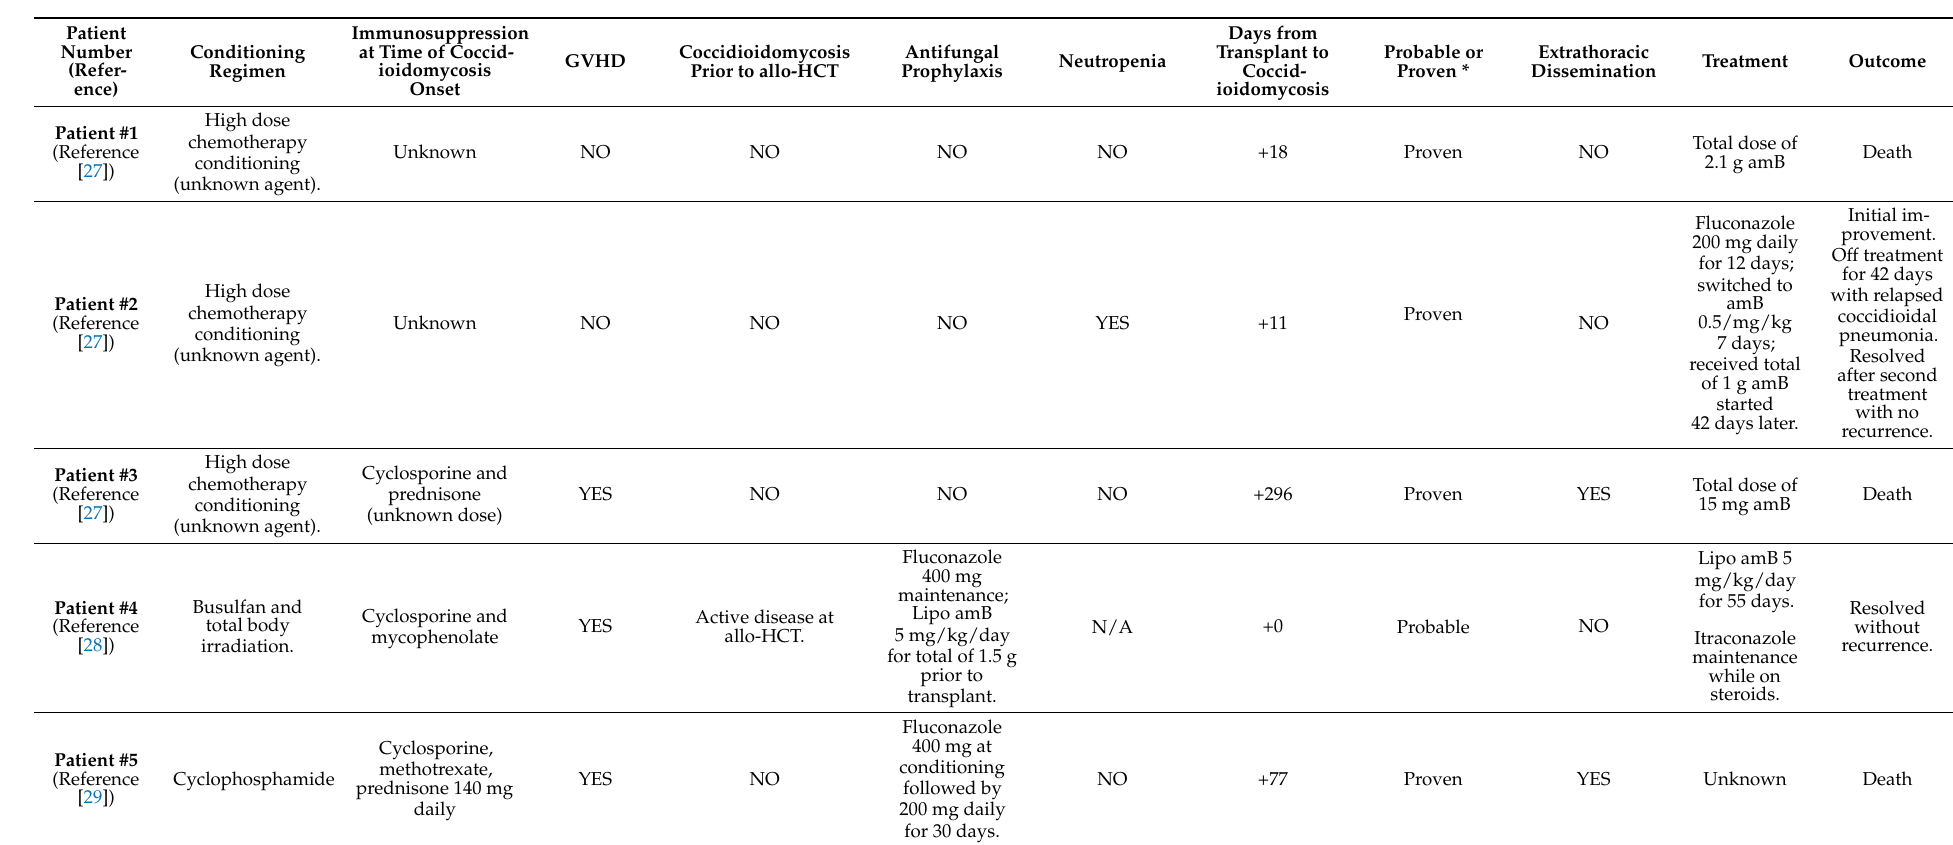
Table 1. Prior described cases of coccidioidomycosis in allo-HCT